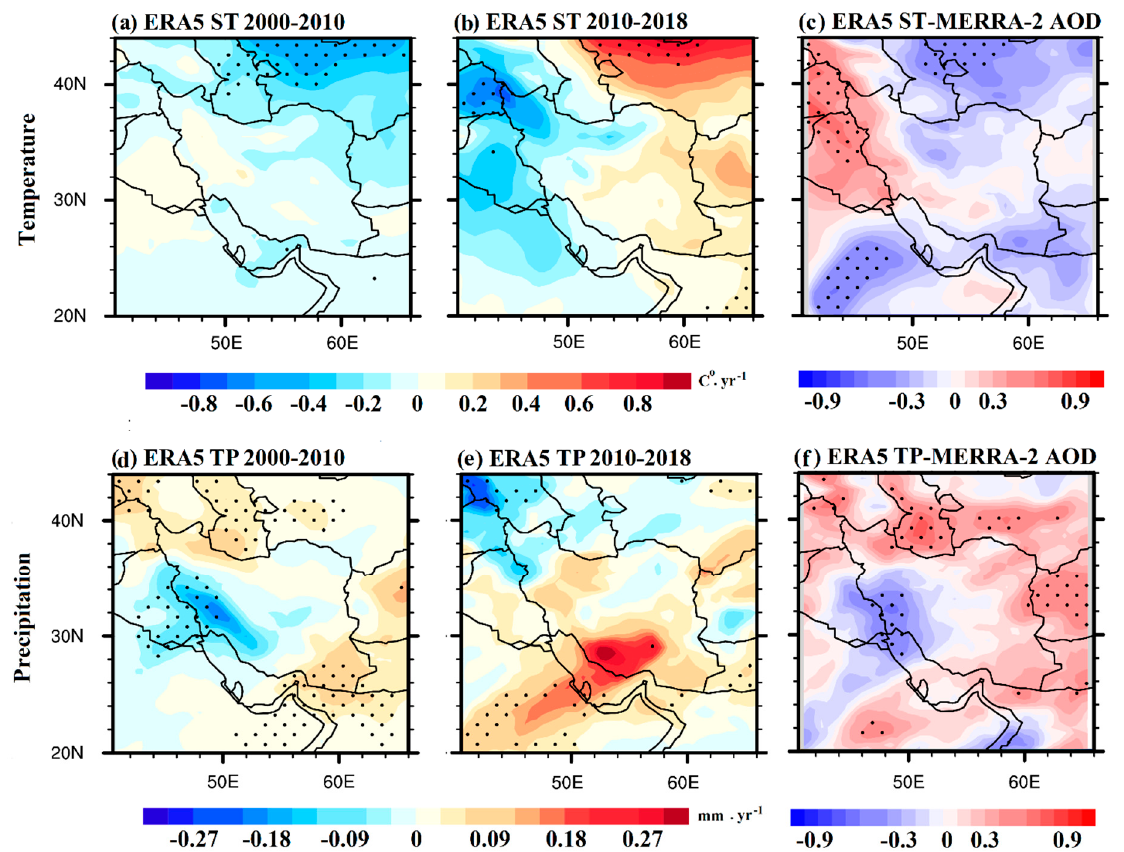
Figure 9. Spatial distributions of the winter (DJF) linear trends in the ERA5-derived surface temperature (ST) and total precipitation (TP) during the periods 2000–2010 ( a , d ) and 2010–2018 ( b , e ) and their respective correlations with the MERRA-2 AODs ( c , f ) calculated during the period 2000–2018. The black dots denote the statistical significance of the trends and correlations at a 95% confidence level ( p < 0.05).